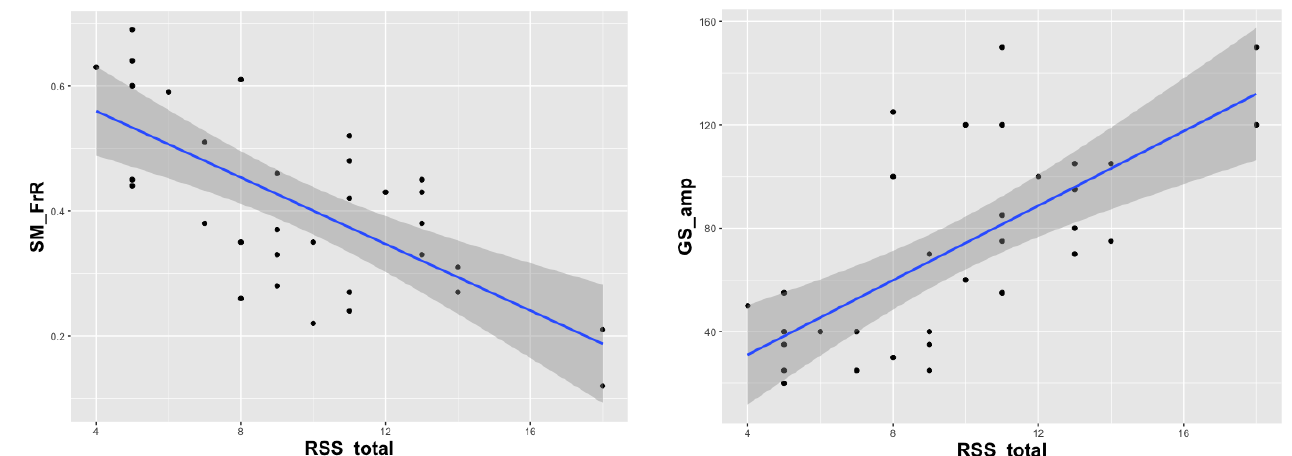
Figure 4. Scatterplots of RSS total scores against the frequency rate of sensorimotor rhythm frequency rate (SM_FrR, r = −0.61, p = 0.0002) and the amplitude of the general slowing of sensorimotor rhythm (GS_amp, r = 0.68, p < 0.0001) for RTT patients (Sp earman’s correlation).